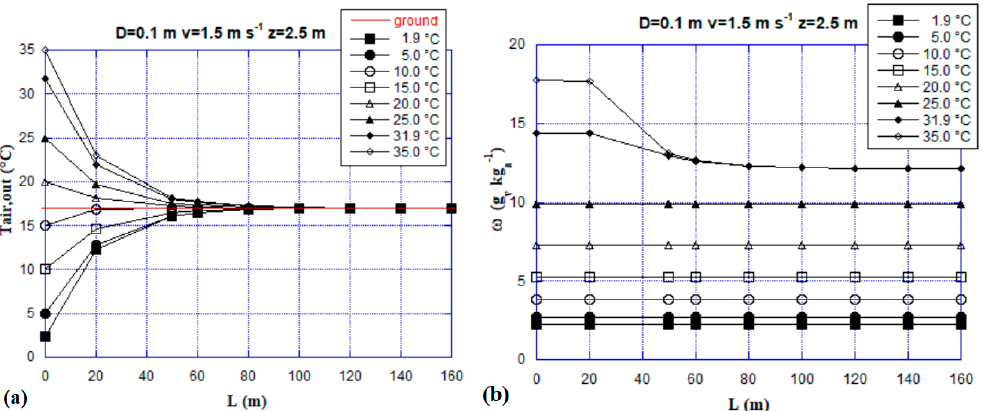
Figure 11. ( a ) Outlet temperature and ( b ) specific humidity, parameterized with respect to inlet temperature of the air flowing with 1.5 m s − 1 in the tube with D = 0.1 m as